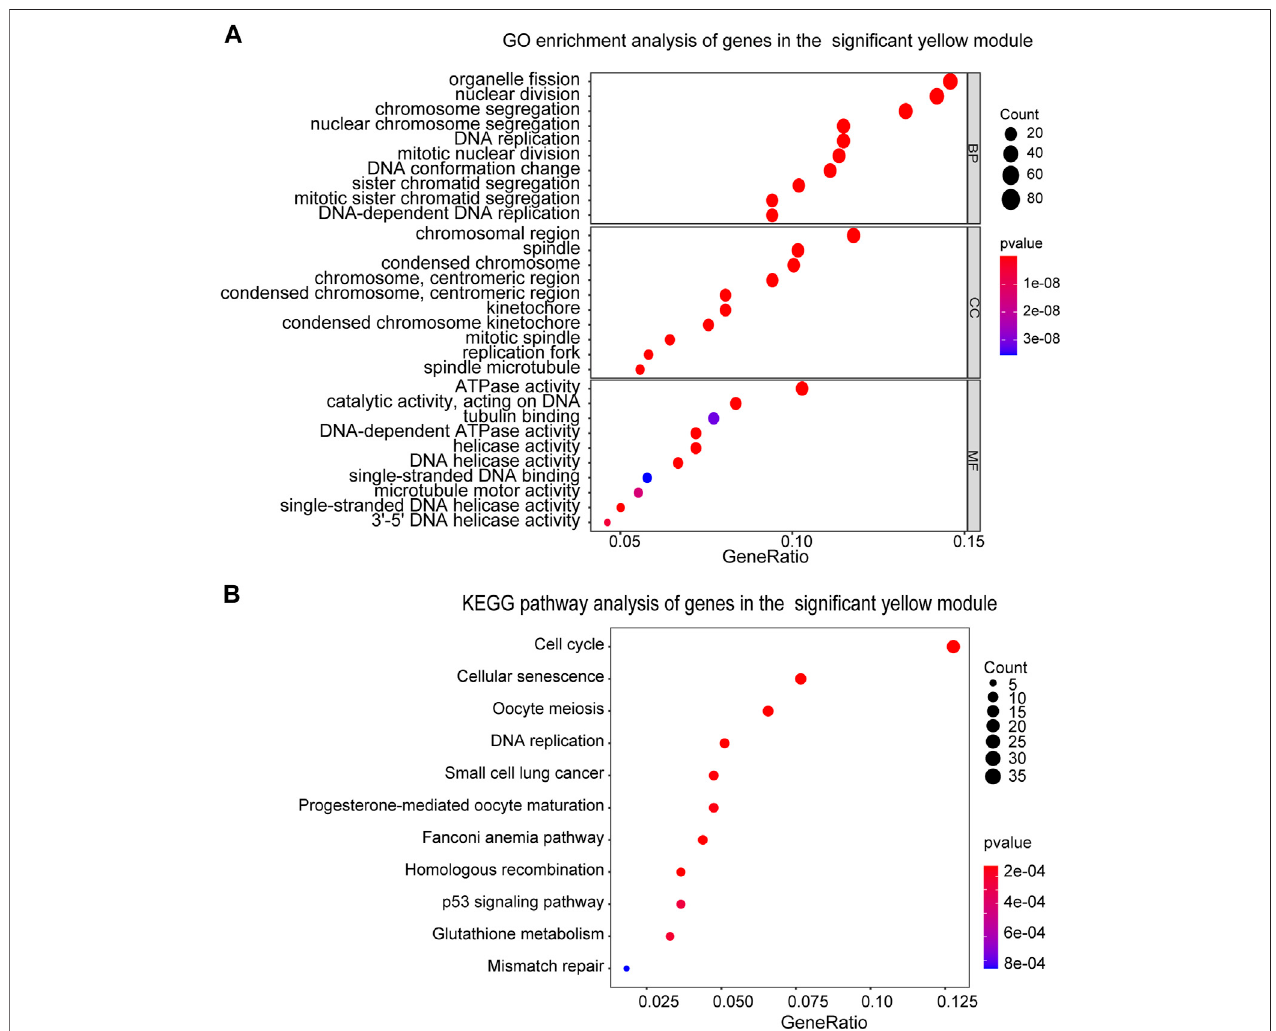
FIGURE 3 | Functional enrichment analysis of genes in the yellow module. (A) GO enrichment analysis of the genes in the yellow module. BP, biological process, CC,cellularcomponent,MF,molecularfunction. (B) KEGGpathwayenrichmentanalysisofthegenesintheyellowmodule.Thesizesofthedotsrepresentthenumberof genes in each